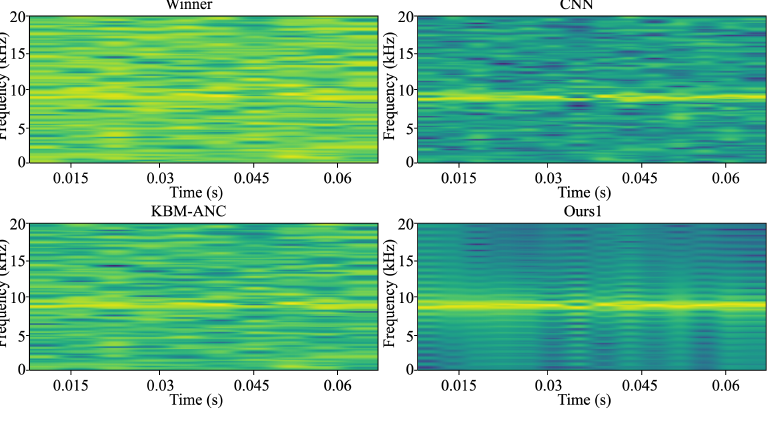
Figure 21. The two-dimensional visualization comparison of the four noise-reduction methods after